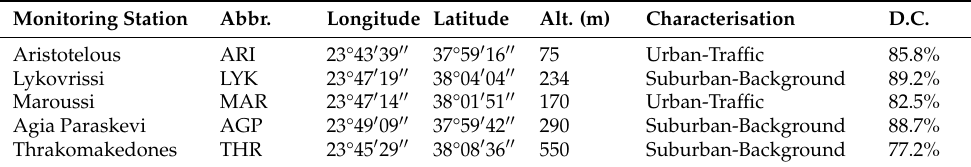
Figure 1. The map of the GAA and the location of the five air pollution monitoring stations. Table 1. The examined air pollution monitoring stations and their characteristics. Abbr. means abbreviation, Alt. means altitude above sea level (a.s.l.) and D.C. means data